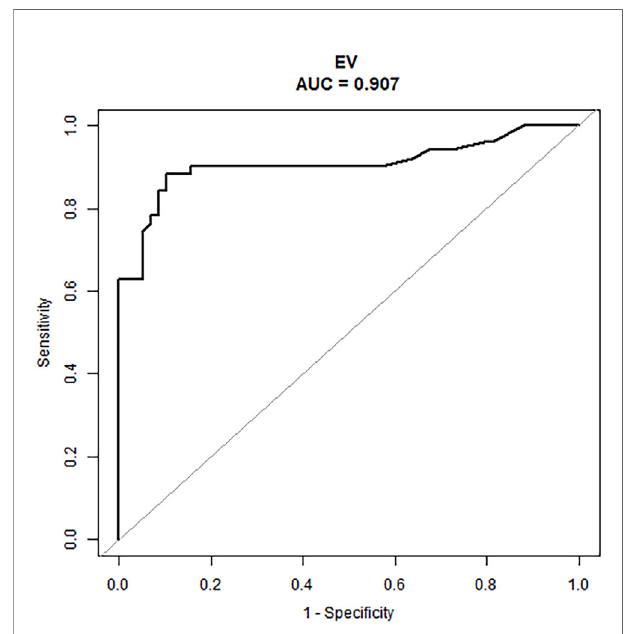
FIGURE 2 | The ROC curves of the prediction model in the primary dataset.